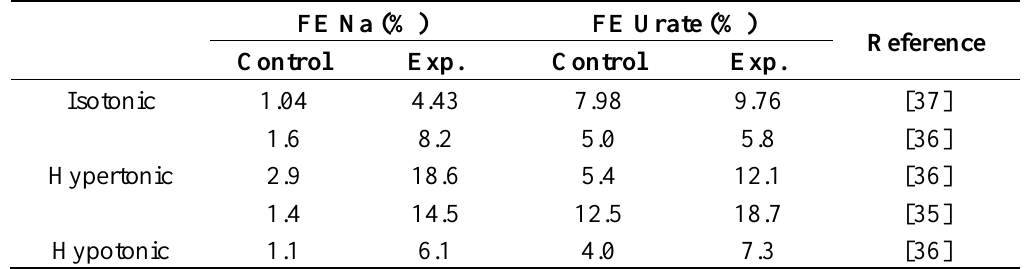
Table 3. Summary of extracellular volume expansion with isotonic, hypotonic and hypertonic saline on fractional excretion of sodium [FEsodium] and urate [FEurate] at control and experimental (Exp.) periods after saline